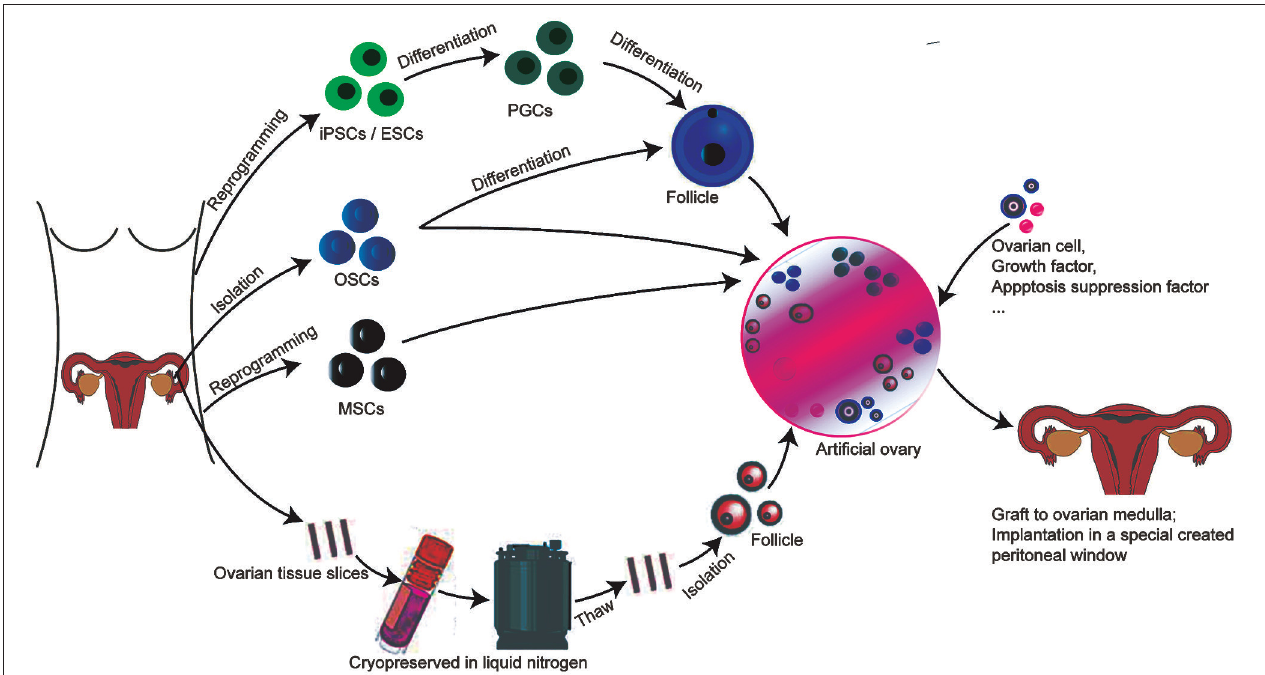
FIGURE 1 | Protocol for constructing an artificial ovary combined with stem cells for patients with BC to preserve fertility and restore endocrine function. (I) If the patient is prepubertal or requires immediate chemotherapy with a potential risk of transmitting malignant cells, ovarian tissue slices are removed and long-term cryopreserved in liquid nitrogen. After thawing, follicles can be isolated from ovarian tissue and then embedded inside a scaffold, we called it “artificial ovary.” (II) Patient-specific induced stem cells, such as PGCs, ESCs, and OSCs, can be differentiated to form follicles and embedded into an artificial ovary. OSCs and MSCs can also be directly placed inside the artificial ovary without differentiation. (III) Other additives can also be added into the artificial ovary, such as ovarian cells, growth factors (VEGF, bFGF), and apoptosis suppression factor (S1P). Finally, this transplantable and functional artificial ovary can be grafted to the ovarian medulla or implantation in a specially created peritoneal